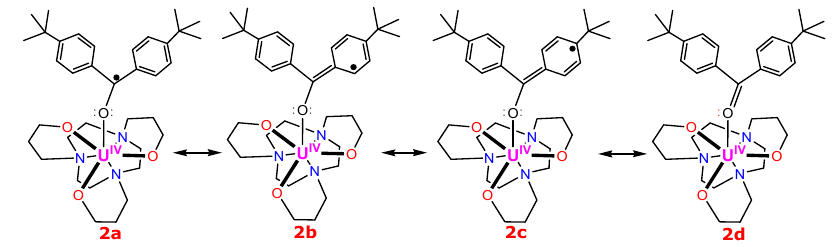
Figure 28. Resonance structures of complex 2 (labelled 2a–2d) [164].